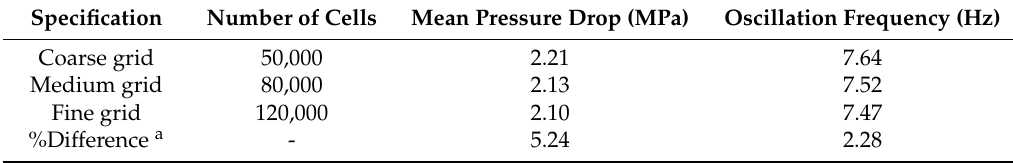
Table 1. The details of the grid independence analysis of a fluidic axial oscillation tool.